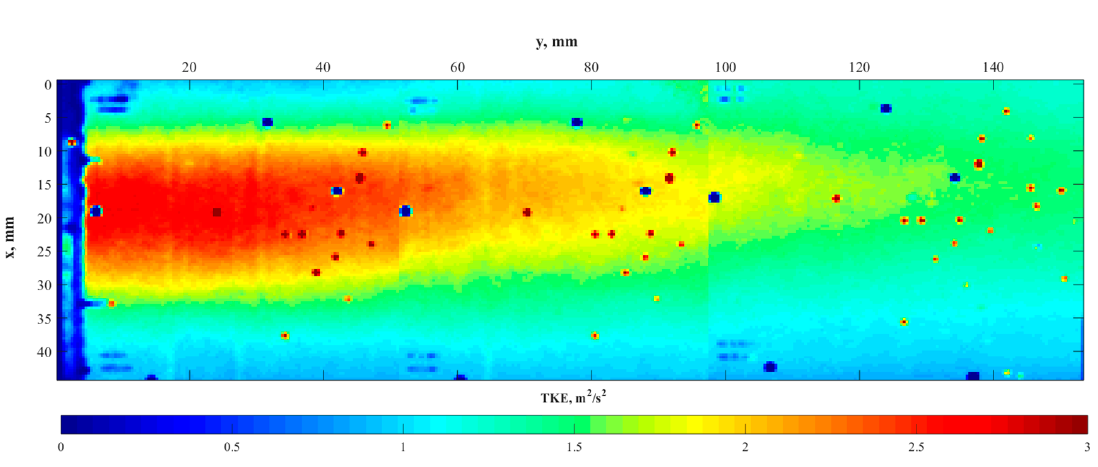
Figure 9. Aeration flow rate ( left ) and pipe cross-sectional void fraction ( right ) induced by the liquid stream at different water volumetric rates. The dynamic pressure, measured by the gauge, resembled the working limits of the pump in the CLR in terms of efficiency (Figure 10).